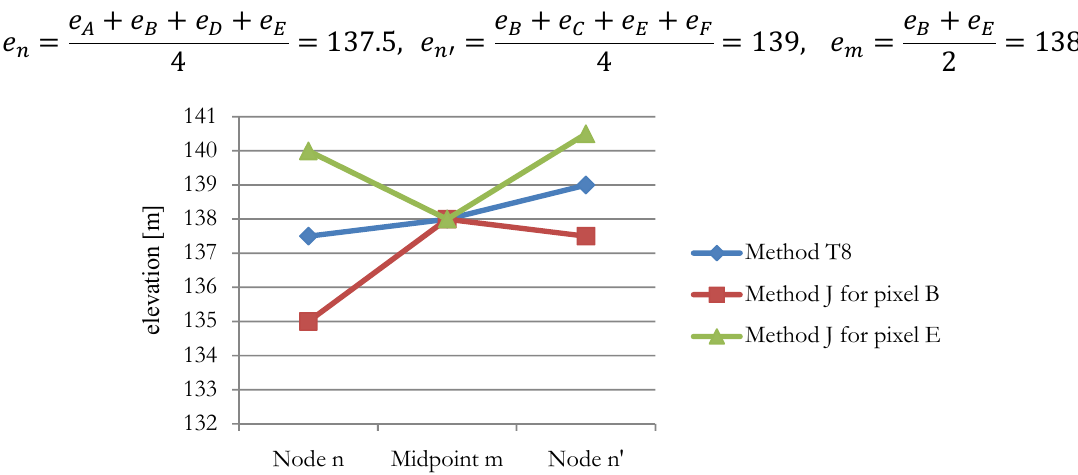
Figure 4. Elevations of the nodes and lengths of the common border.